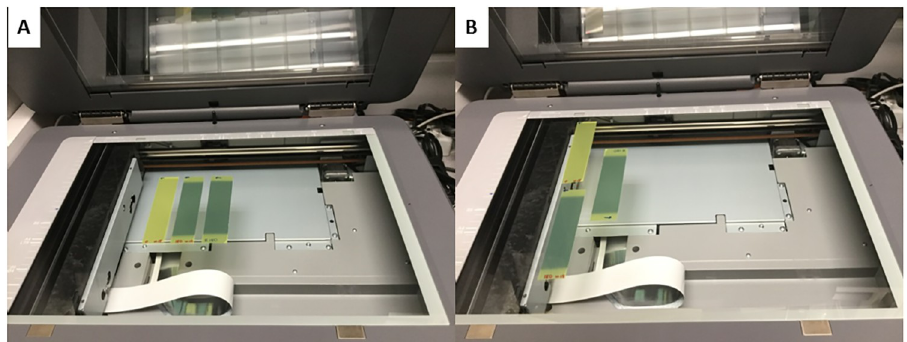
Fig 2. Orientation of radiochromic film. A) Film aligned centrally on the flatbed scanner. B) Film placed improperly on the flatbed